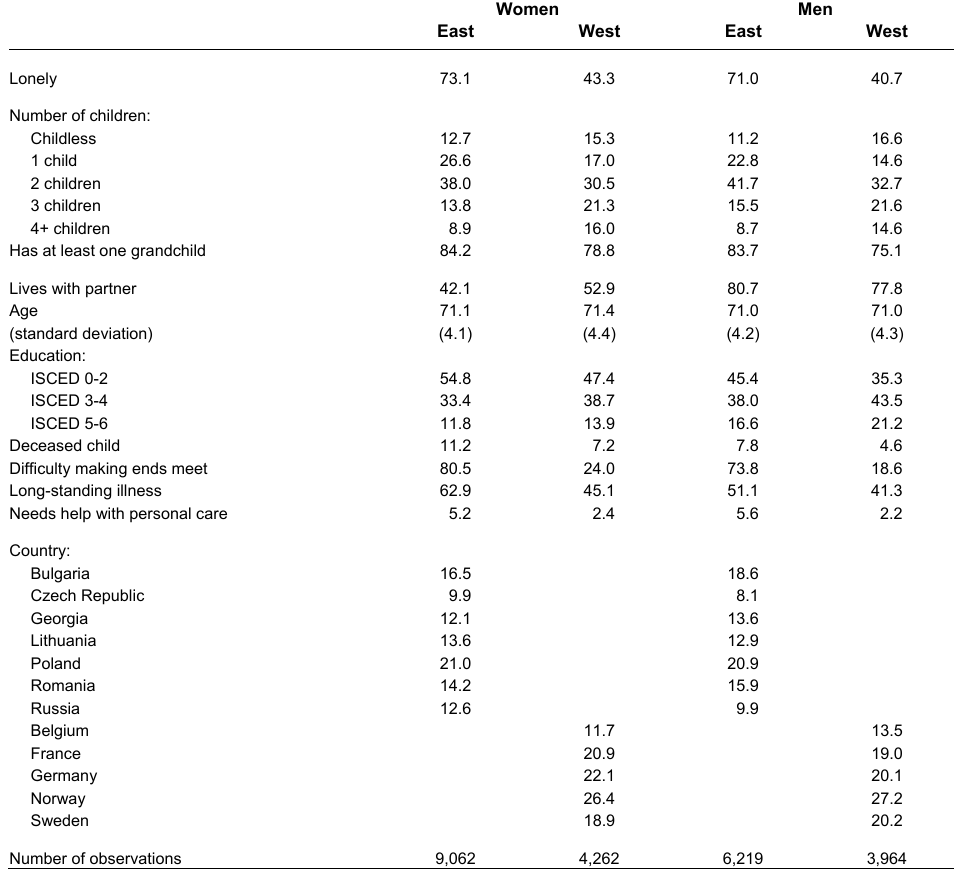
Table 1 : Sample characteristics; means and percentages Women Men East West East West 73.1 43.3